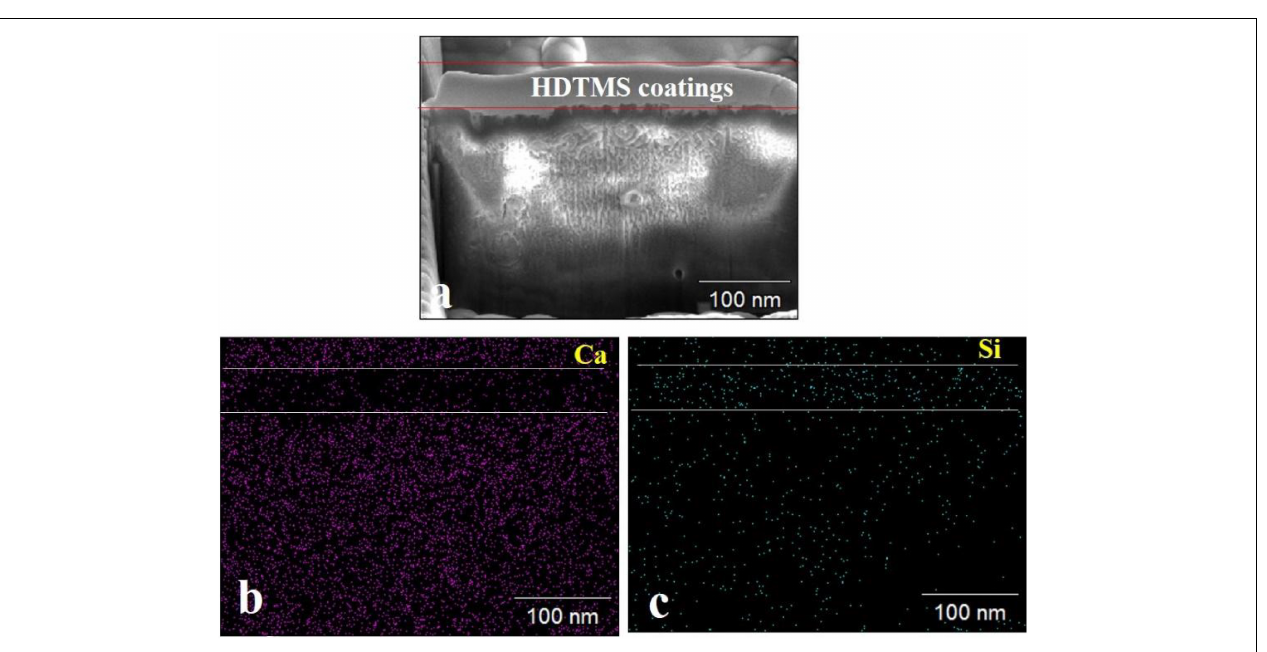
Frontiers in Microbiology |